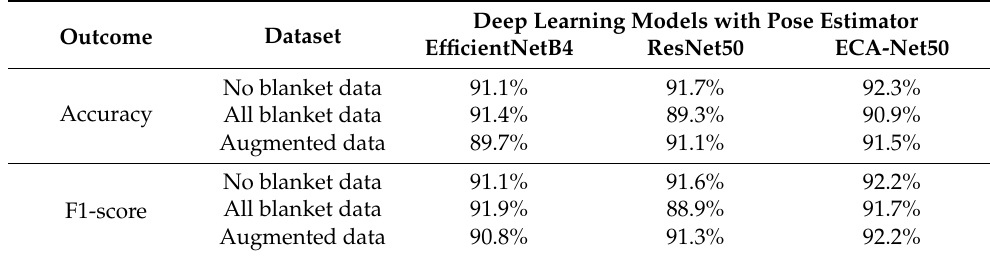
Table 3. Performance of deep learning models (EfficientNetB4, ResNet50, and ECA-Net50) with pose estimator input trained using datasets with no blanket, all blankets, and augmented